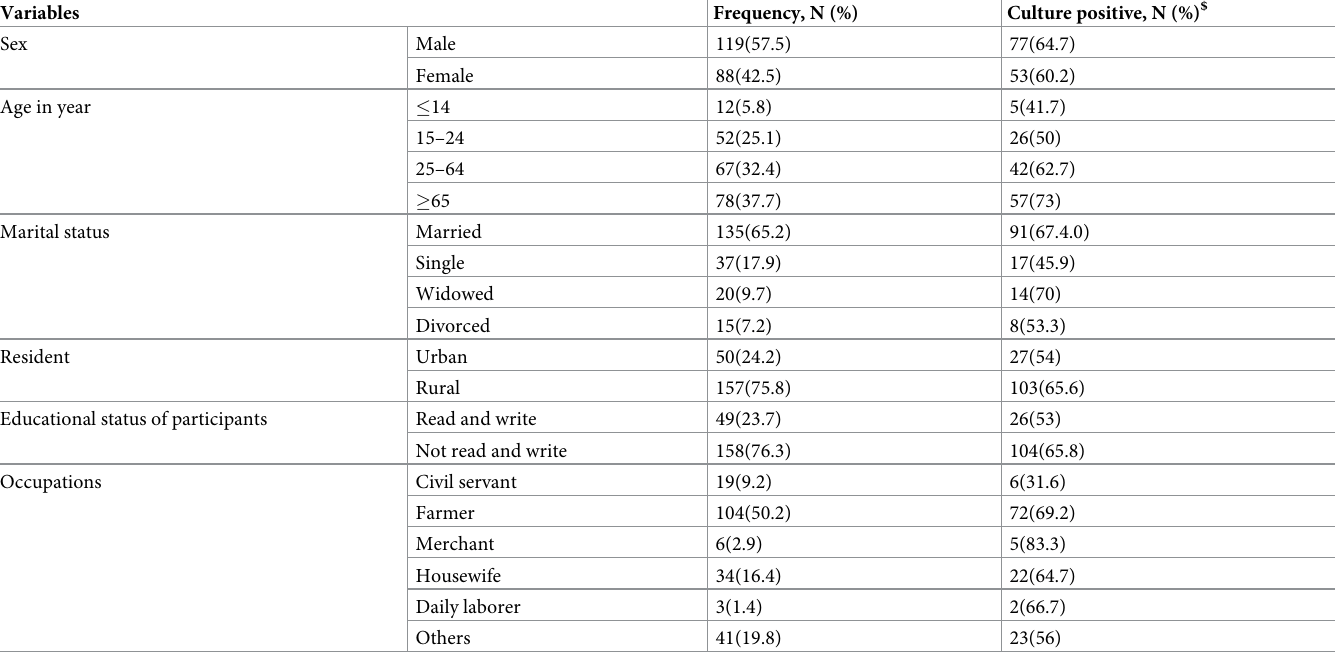
Table 1. Prevalence of culture-confirmed bacteria stratified by socio-demographic characteristics of the study participants at DMCSH, Northwest Ethiopia, 2021.